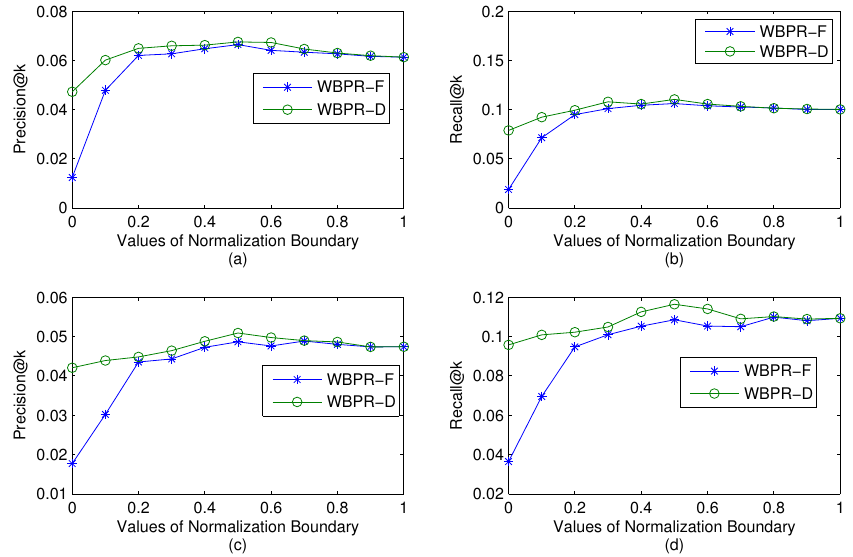
Figure 7. Impact of normalization boundary of the weight factors on the recommendation performance in Gowalla and Brightkite (dimensionality = 10, k = 5). ( a ) Precision @ k in Gowalla; ( b ) Recall @ k in Gowalla; ( c ) Precision @ k in Brightkite; ( d ) Recall @ k in